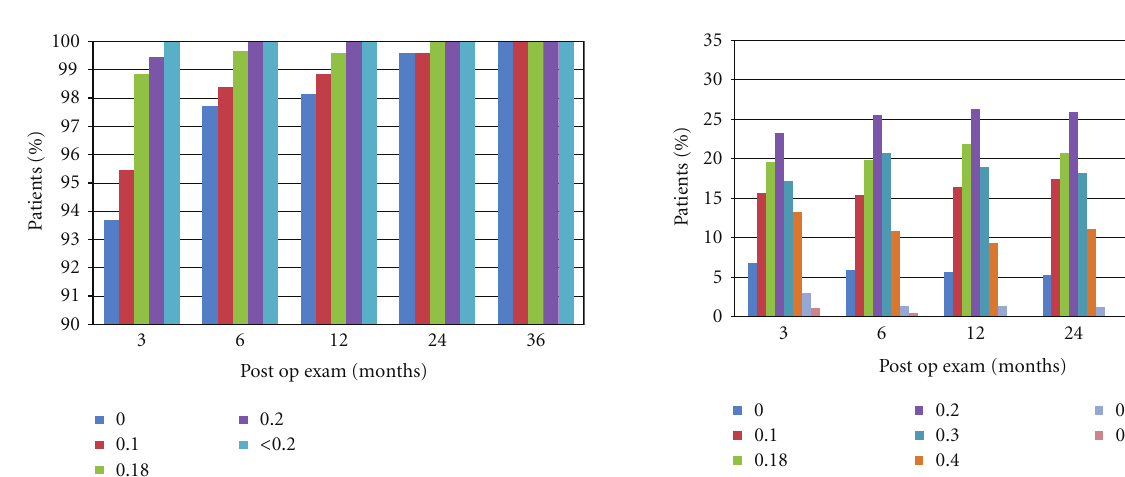
Figure 3: Post-op UNVA in di ff erent periods of followup.